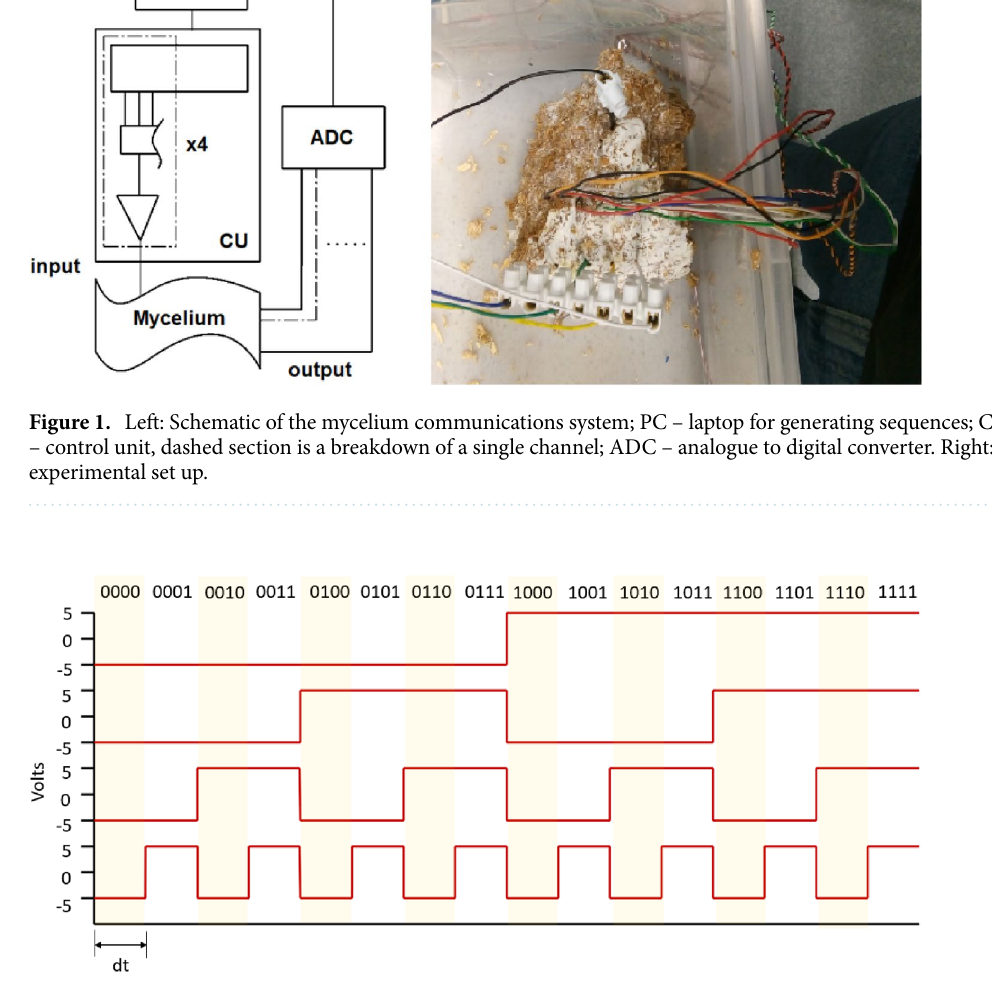
Figure 2. Timing diagram and associated Boolean strings for four inputs into the mycelium substrate, time step is 1